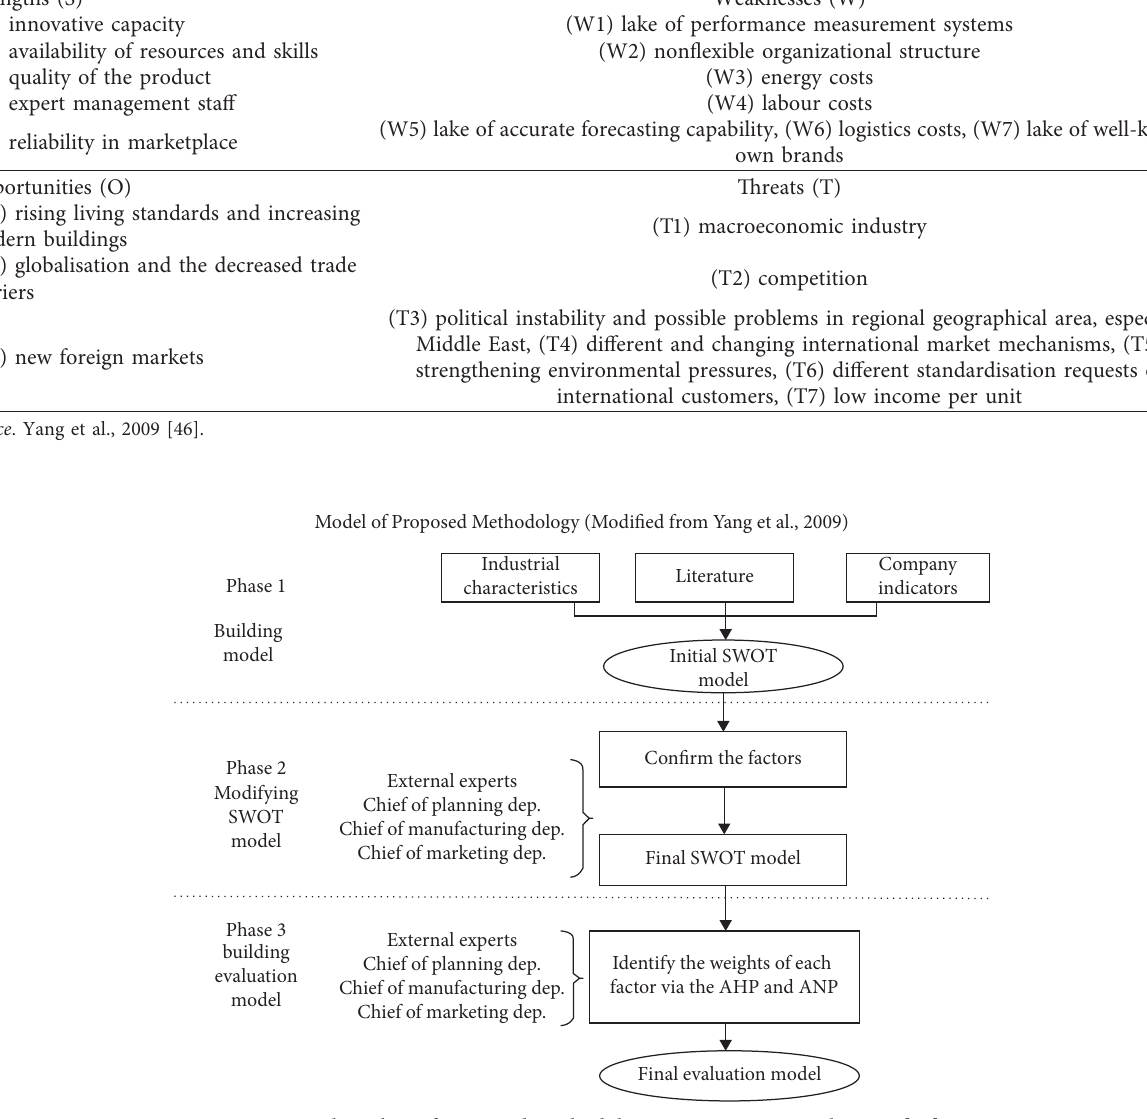
Figure 2: Algorithm of proposed methodology. Source: Yang et al., 2009